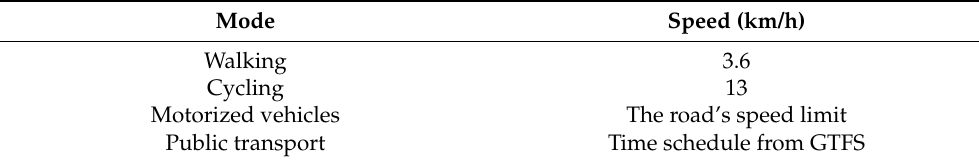
Table 2. Speeds of transport modes used for computation, as defined in the UrMoAC tool.